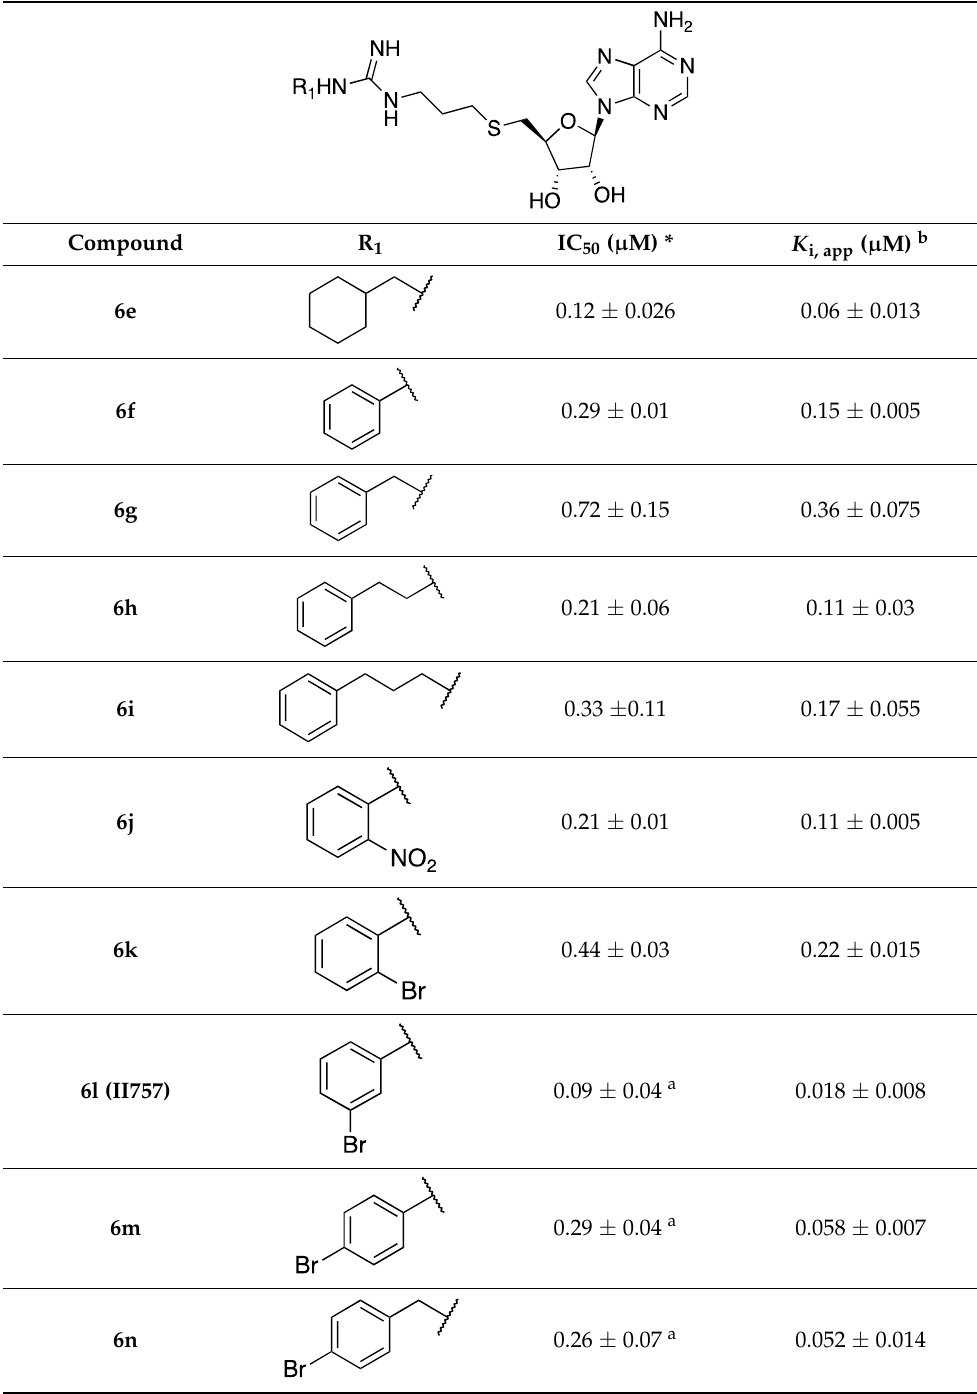
Table 1. Cont. Table 1. SAR of synthesized compounds 6a–6n .